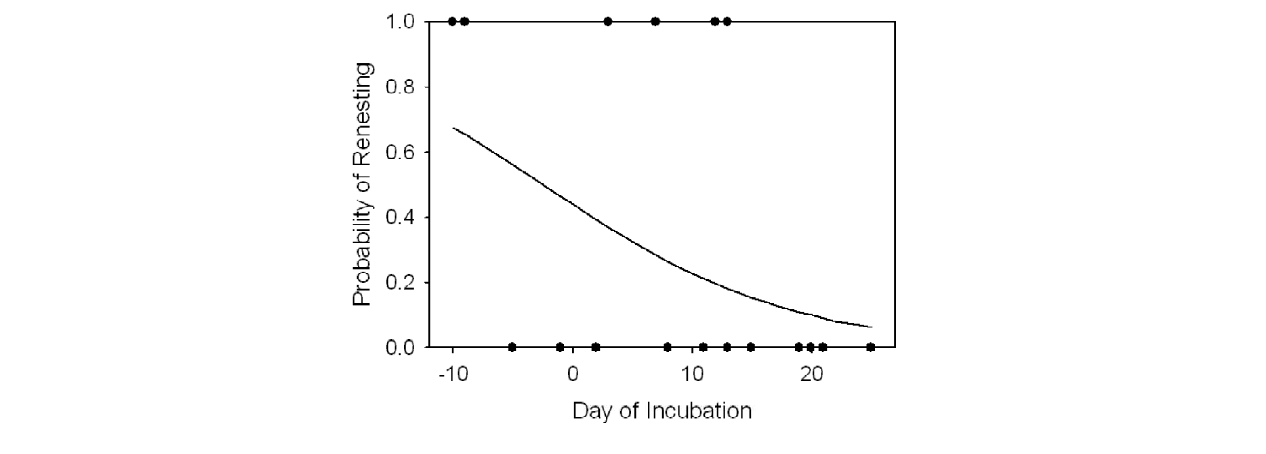
Fig. 1 . Probability of renesting as a function of the stage of development of the first nesting attempt when the nest was destroyed. First nests of 23 females were destroyed by natural causes at prairie sites in northeast Kansas, 2003-2005. Points on the x-axes represent females which renested (y = 1) or did not attempt renesting (y = 0). Nests with negative values for day of incubation were destroyed during egg